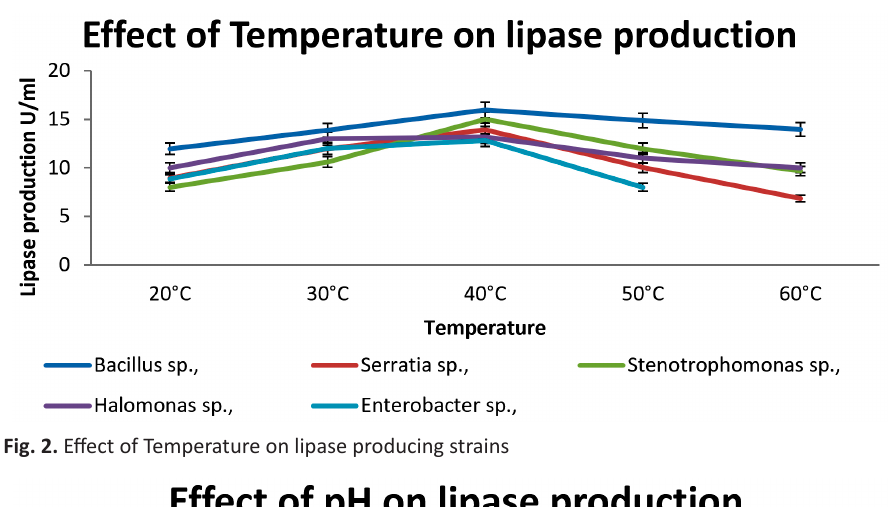
Fig. 2. Effect of Temperature on lipase producing strains